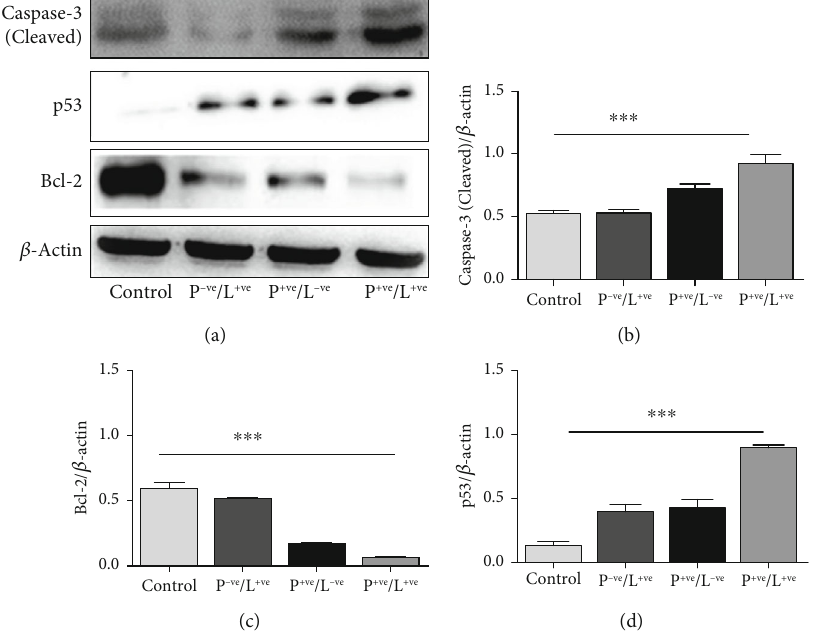
Figure 3: Western blotting expression of apoptotic proteins in TE 354.T cells following AE-mediated PDT. (a) The cells were treated with 5 μ M AE, irradiated for 10min, and protein lysates were collected 12 hours later for western blotting assays. (b – d) Quantitative analyses of change of cleaved caspase 3, Bcl-2, and p53, respectively ( ∗∗∗ p < 0 : 0001 ). Protein level was expressed as mean ± SD from three independent experiments. Control (P-L-), light irradiation only (P-L+), AE only (P+/L-), and AE-mediated PDT